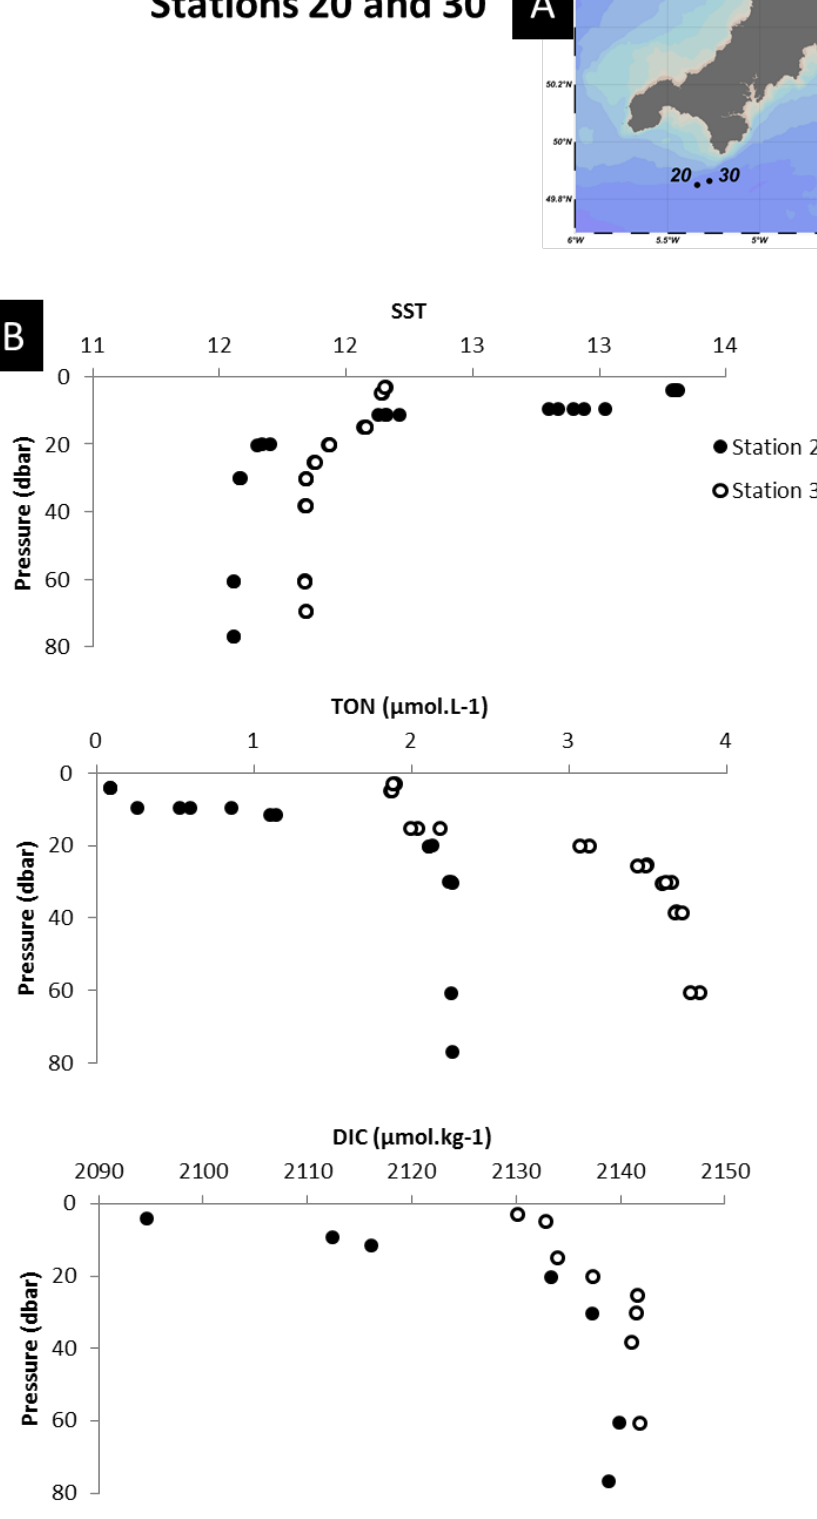
Figure 9. Impact of storm mixing on sea surface pH. ( A ) Location of station 20 sampled on the 15 June 2011 and station 30 sampled on the 30 June 2011 south of Cornwall (UK). ( B ) Depth profiles of temperature (SST), nitrate and nitrite (TON) and DIC at the two stations. Map was produced using Ocean Data View (Schlitzer, R., Ocean Data View, odv.awi.de, 2017).